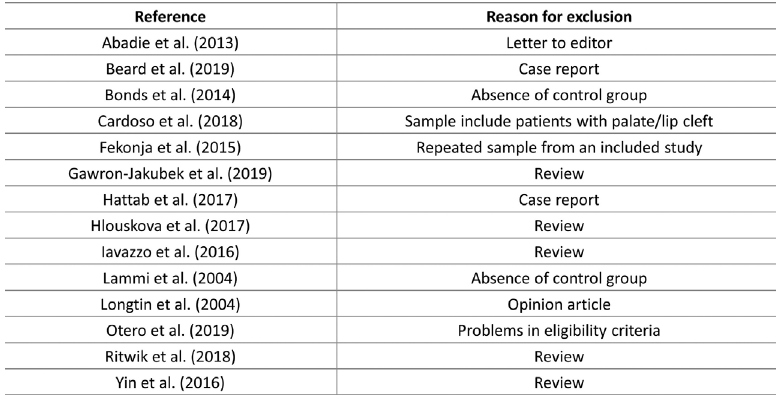
Figure 2- List of excluded studies with reasons for